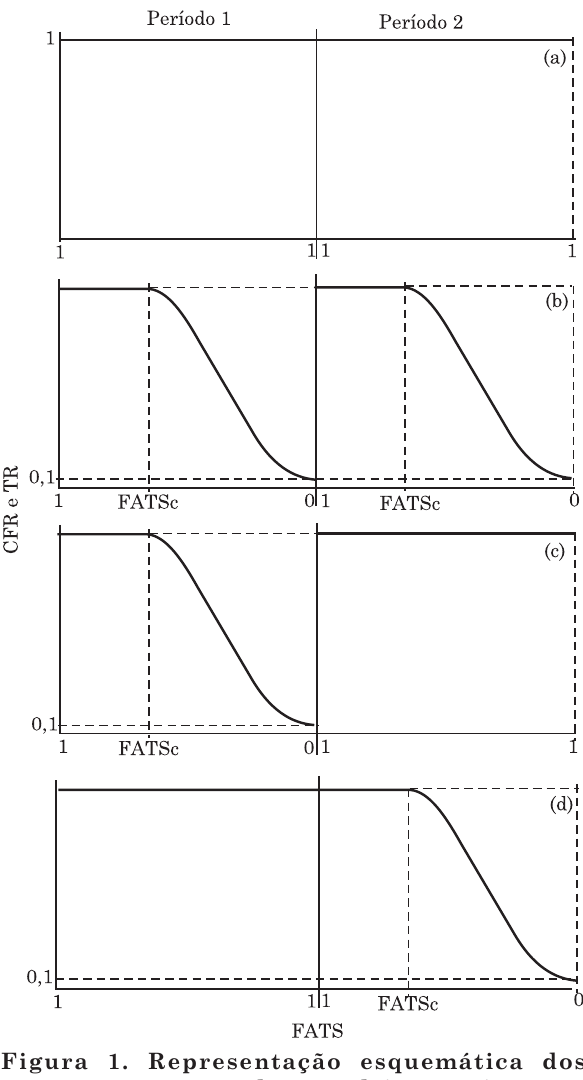
Figura 1. Representação esquemática dos tratamentos usados nos dois experimentos, referente à resposta do crescimento foliar relativo (CFR) e da transpiração relativa (TR) em função da fração da água transpirável do solo (FATS), em regimes hídricos com irrigação (RH1) (a) e sem irrigação (RH2) (b) nos dois períodos; sem irrigação somente no período 1 (RH3) (c) e somente no período 2 (RH4)